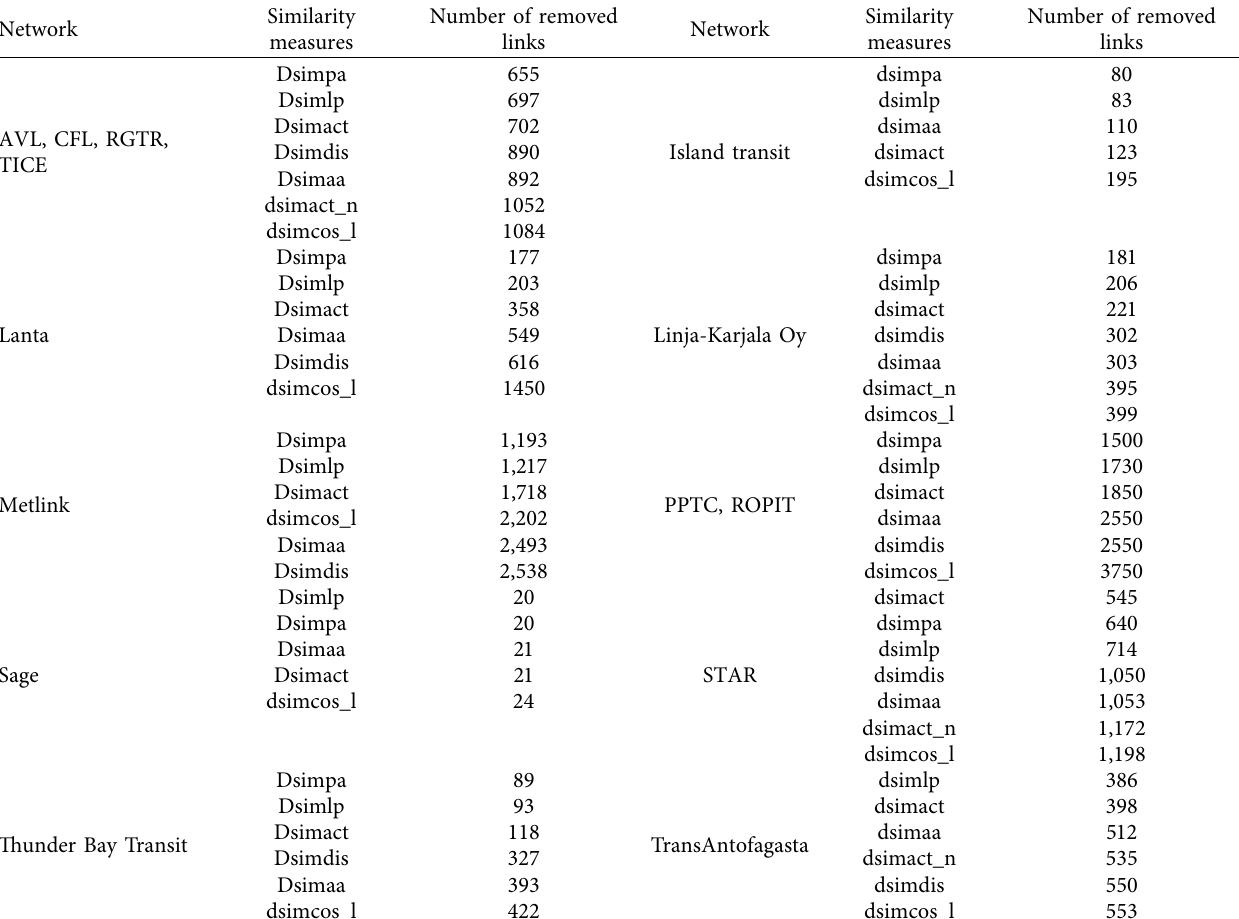
Table 11: Number of removed links that cause a 75% of reduction in the